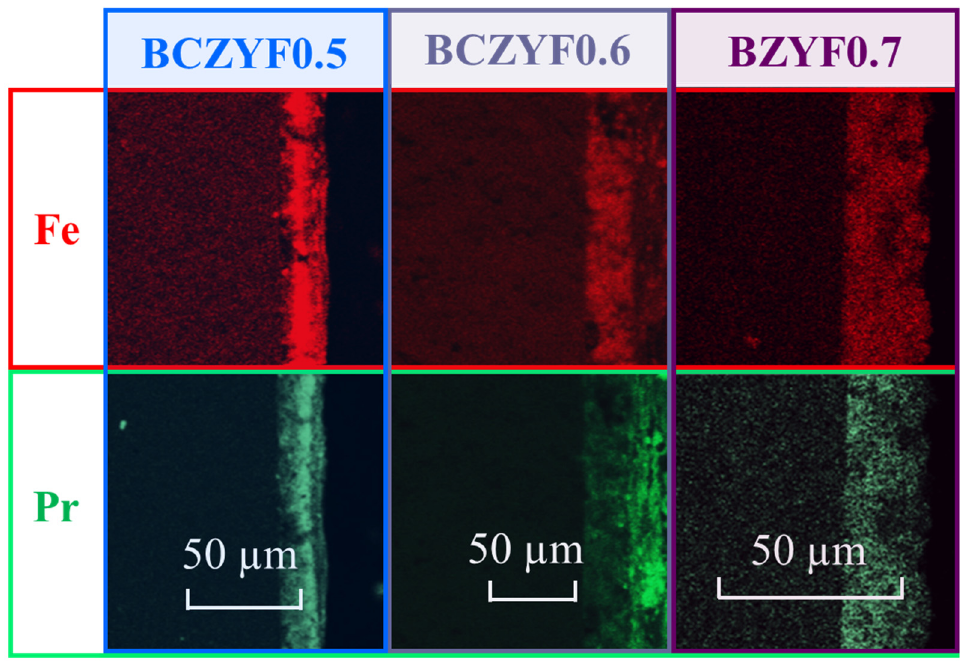
Figure 4. Distribution maps of iron and infiltrated praseodymium in the porous cathodes after isothermal treatment at 600 °C.